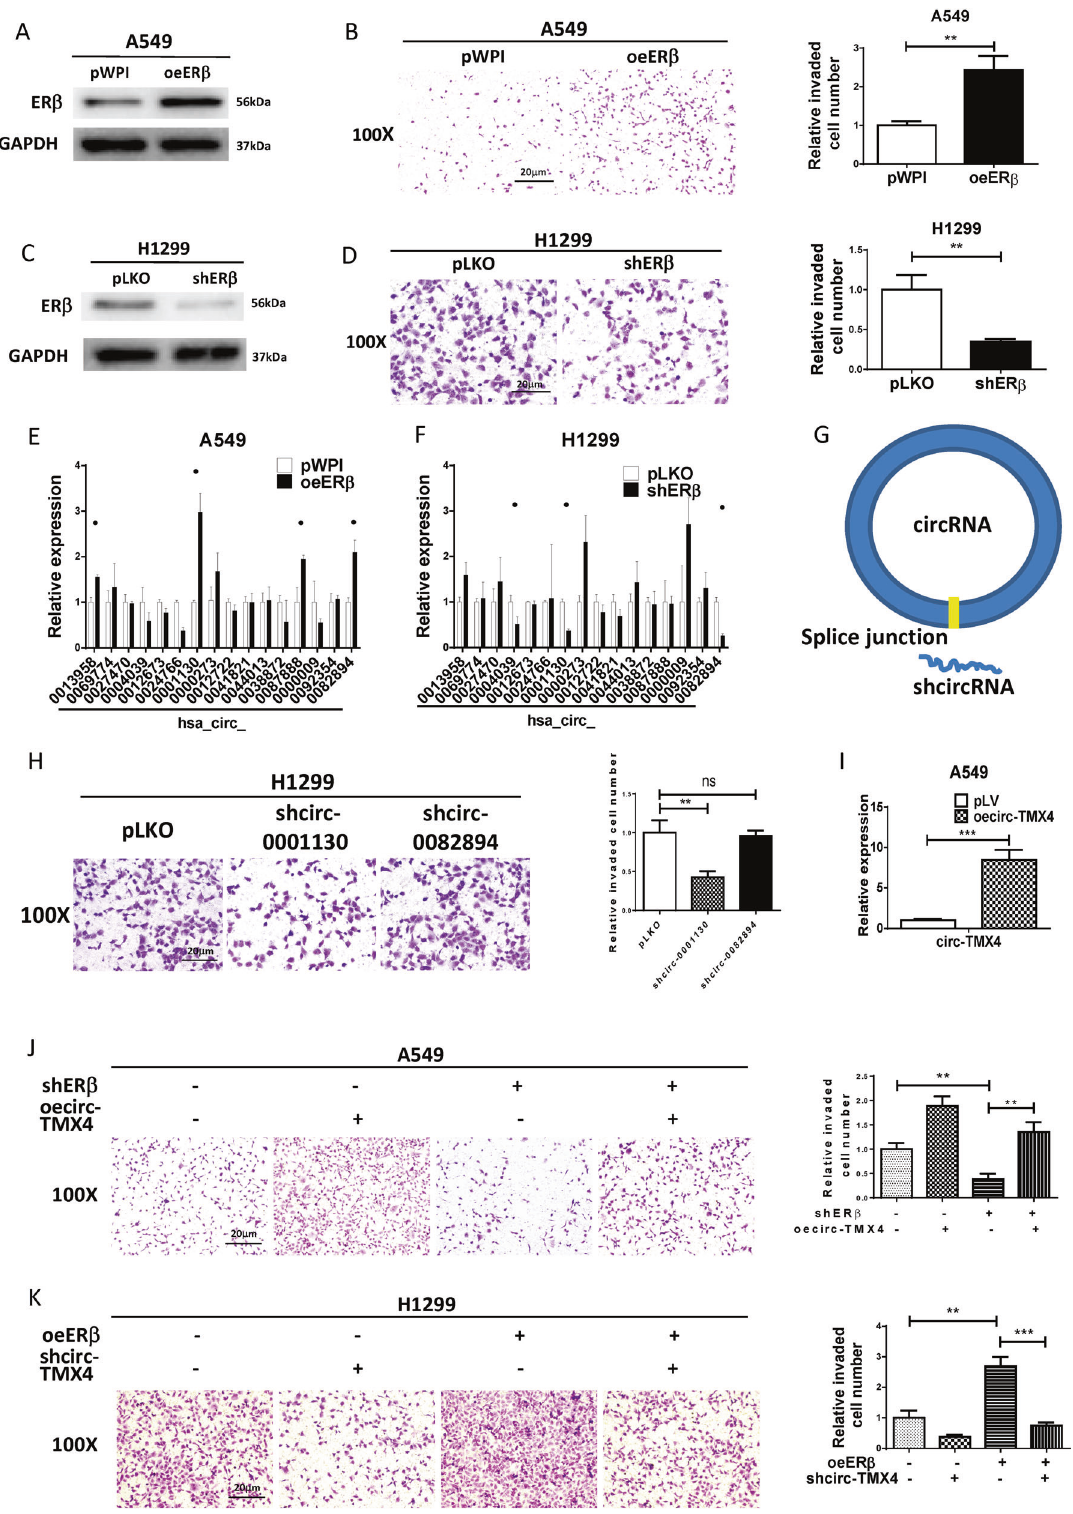
(oeER β ) to A549 cells (Fig. 1A), and found that oeER β promoted A549 cell invasion signi fi cantly (Fig. 1B). In contrast, ER β levels were decreased after adding ER β -shRNA (shER β ) to H1299 cells with high ER β expression (Fig. 1C), and shER β led to decrease signi fi cantly lung cancer cell invasion (Fig.